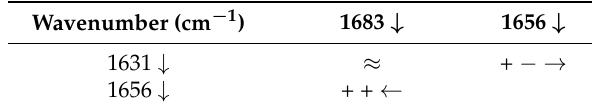
Table 3. Correlation table for deconvolved FTIR spectra of CCFs (5% w / v in D 2 O) during heating (5 → 70 ◦ C, in increment of 5 ◦